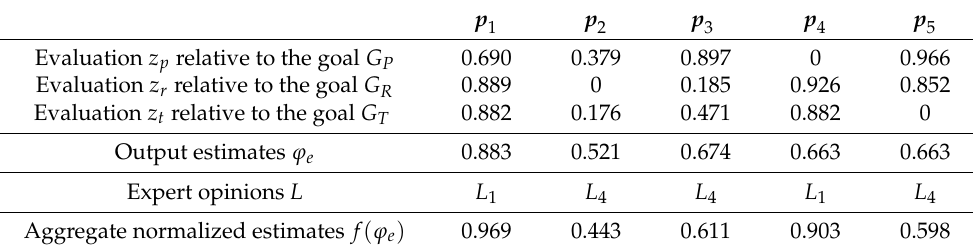
p p p p p 1 2 3 4 5